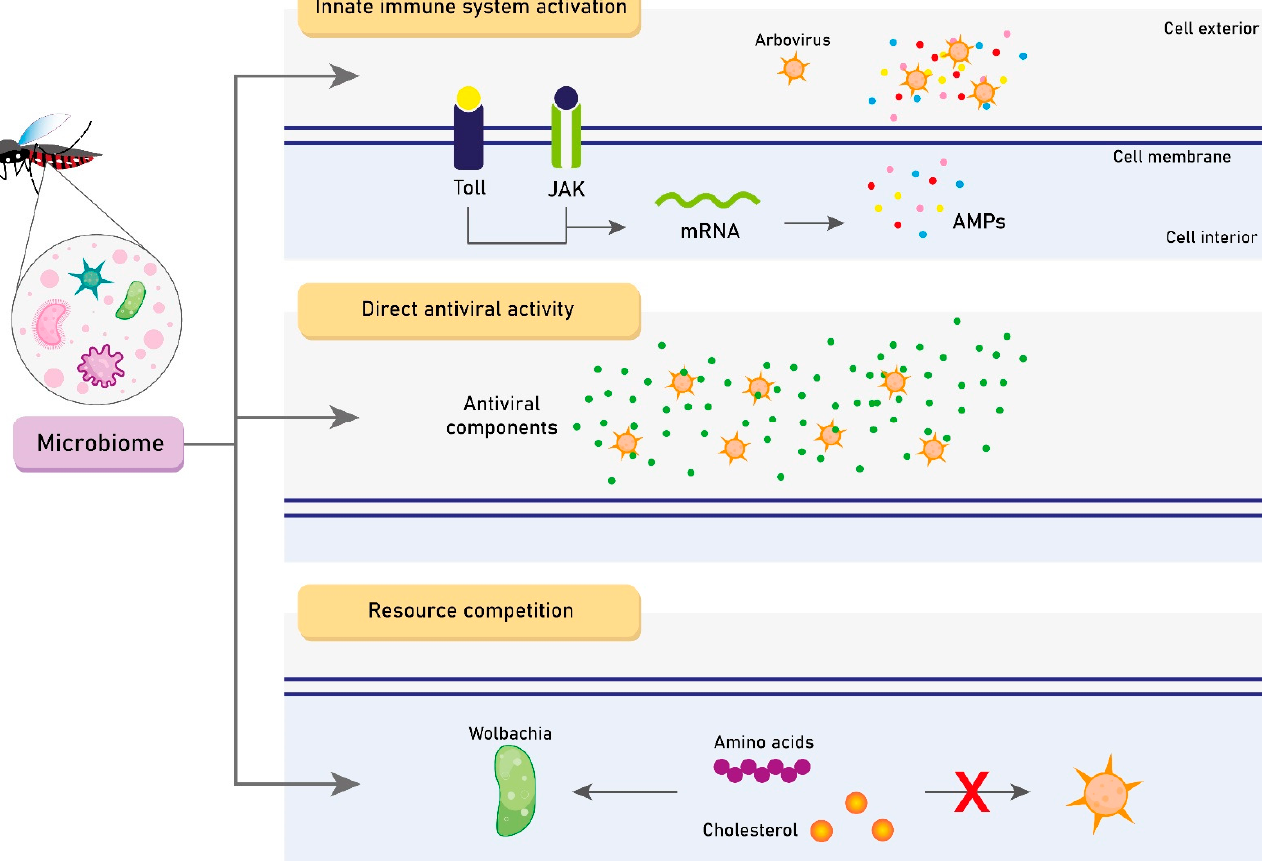
Figure 2. The three main hypotheses of microbiome-driven mechanisms for modulating Aedes spp. vector competence. JAK: Janus kinase. AMP: Antimicrobial peptide. Created with Adobe Illustrator.